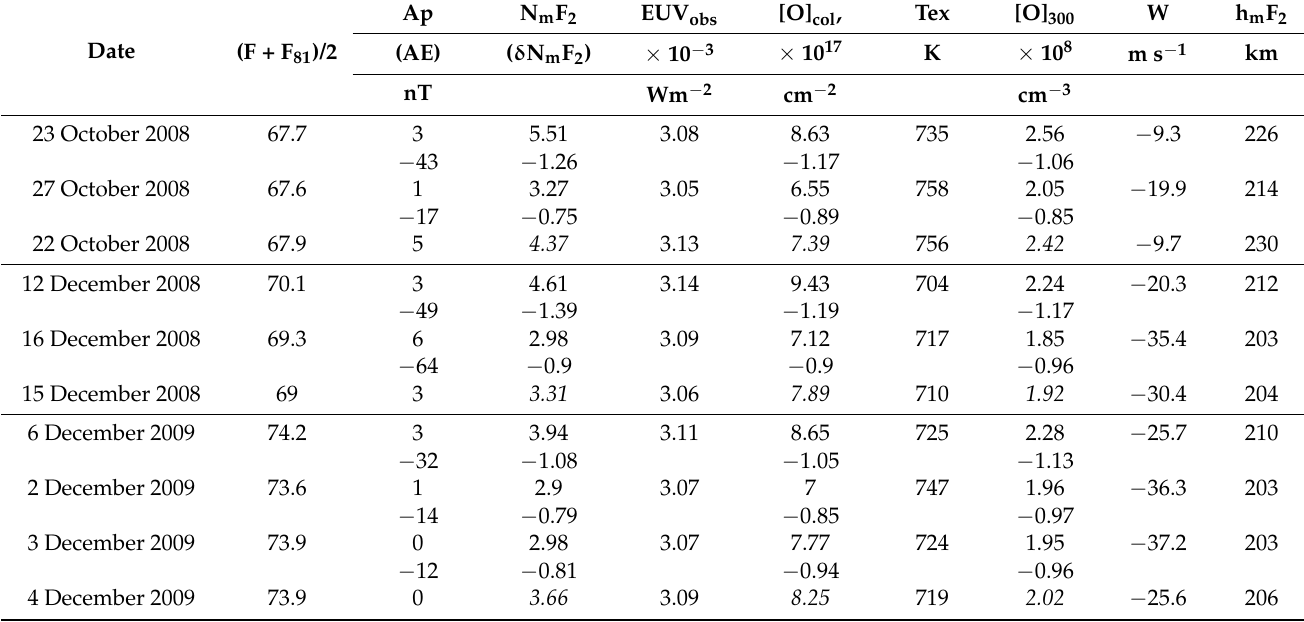
Table 2. Same as Table 1 but for